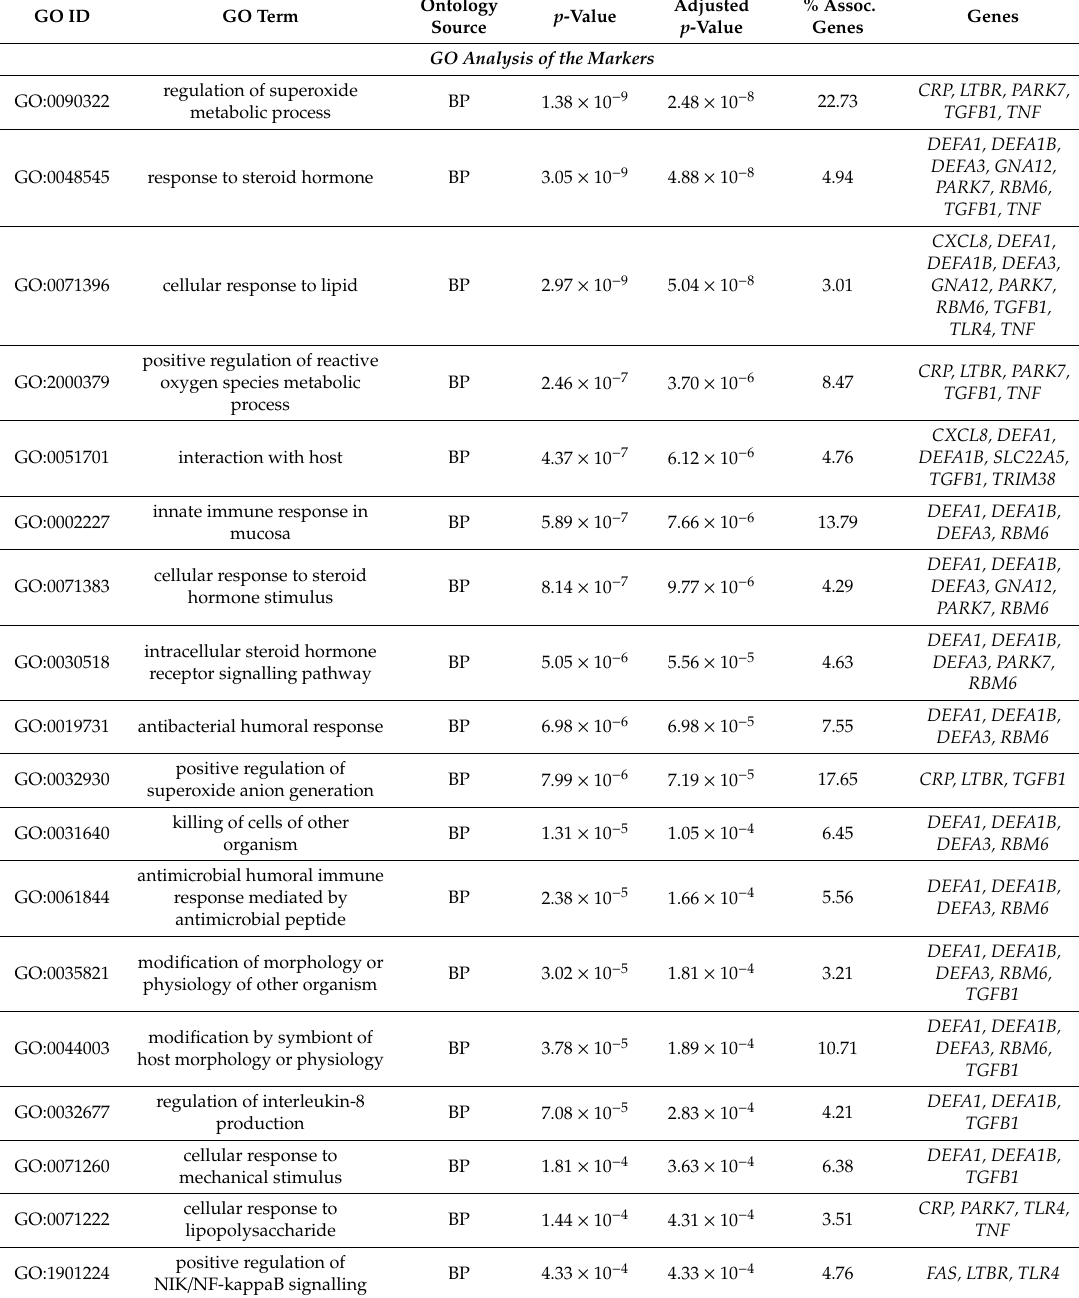
Table 6. GO analysis of the integrated blood markers linked to the short-term anti-TNF therapy response in CD